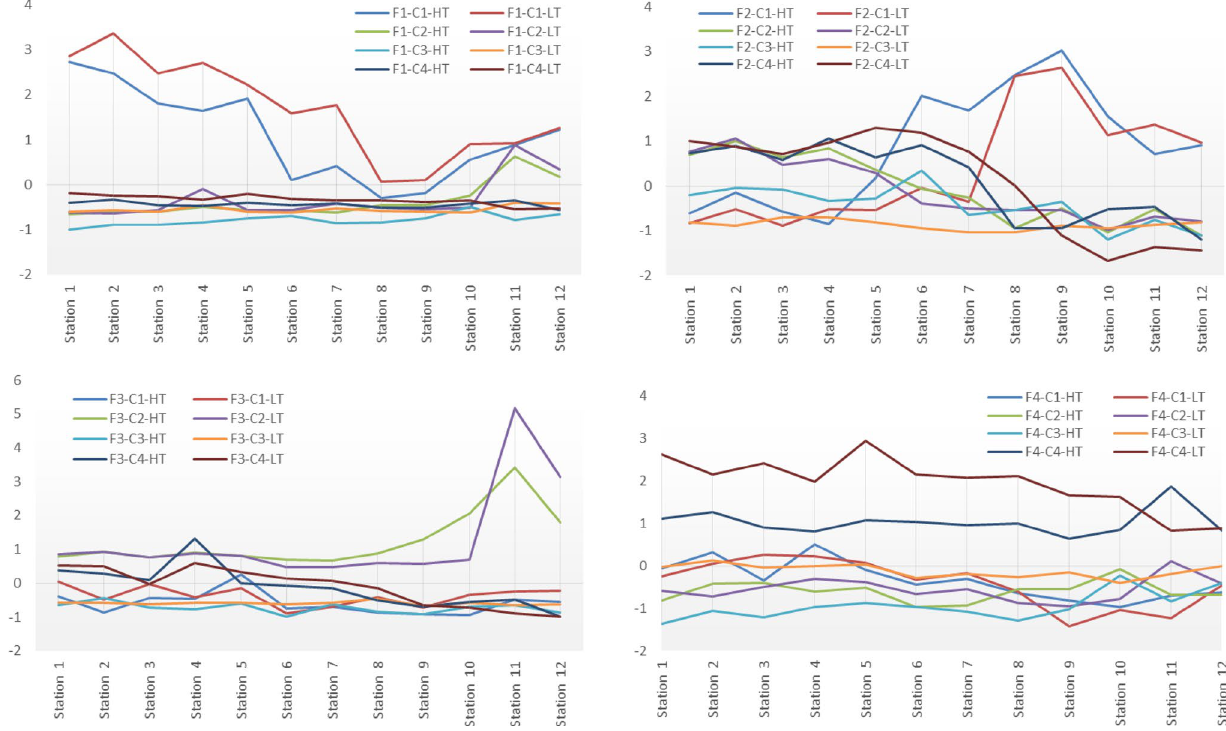
Fig. 7 Spatial distribution of the factors extracted from factor analysis (FA). F1 – F4 denote the four factors extracted, C1 – C4 denote sam- pling cycles where C1 pr-monsoon, C2 -monsoon, C3 post-monsoon,